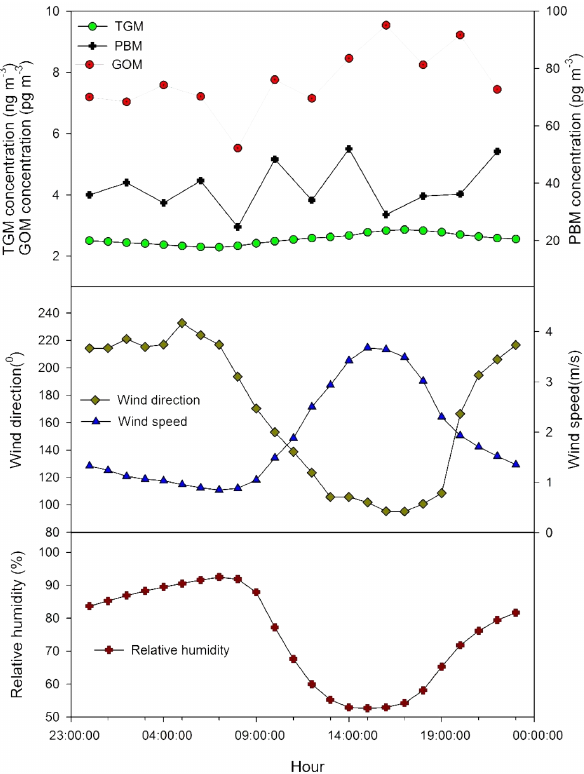
Figure 4. The diurnal variation in TGM, GOM and PBM with WD,WS and